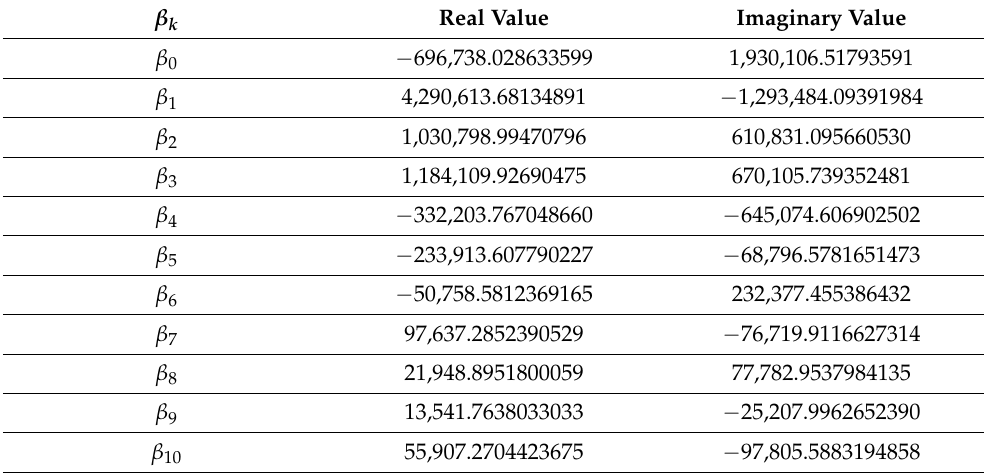
Table 4. The real values and imaginary values of the complex coefficients β k